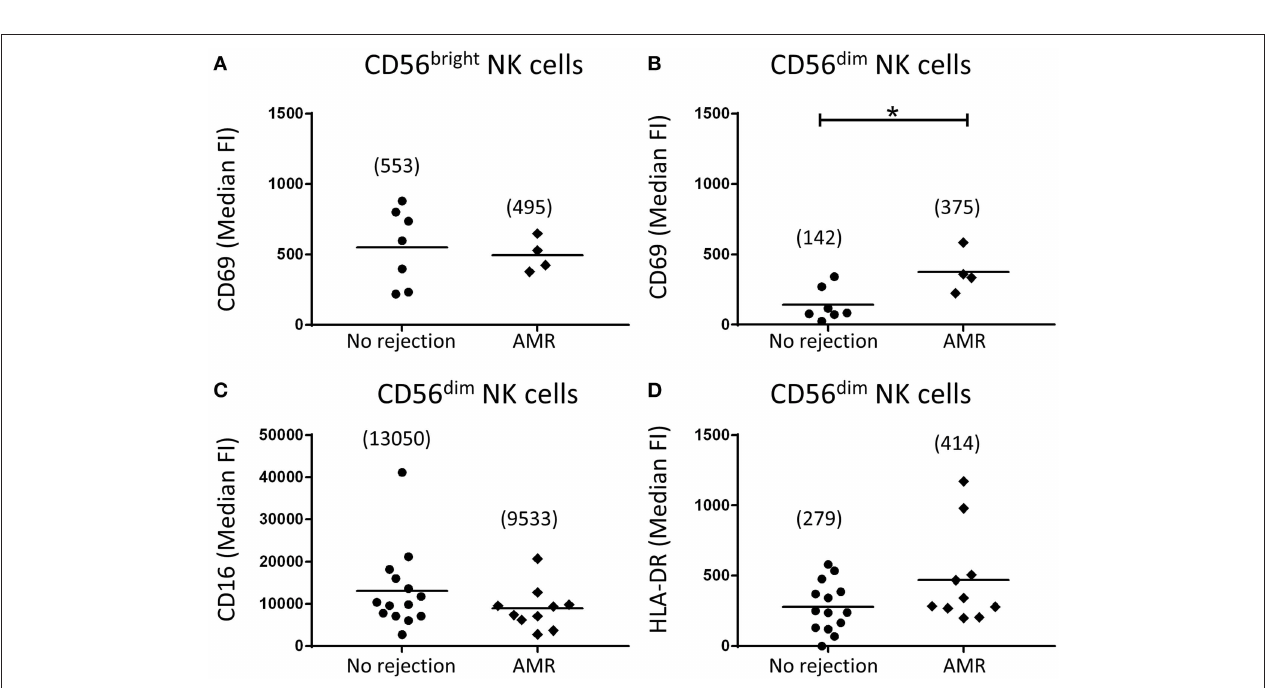
FIGURE 6 | Human CD56 dim natural killer (NK) cells in AMR biopsies display an activated phenotype. (A,B) Surface expression of CD69 on CD56 bright NK cells (A) and CD56 dim NK cells (B) in biopsy specimens without (no rejection; n = 7) and with AMR ( n = 4). (C,D) Surface expression of (C) CD16 and (D) HLA-DR on CD56 dim NK cells in biopsy specimens without (no rejection; n = 14) and with AMR ( n = 10). Median fluorescence intensity (median FI) values for individual donors are shown; bars represent means, with mean values presented in parentheses. * P < 0.05, Mann-Whitney test.